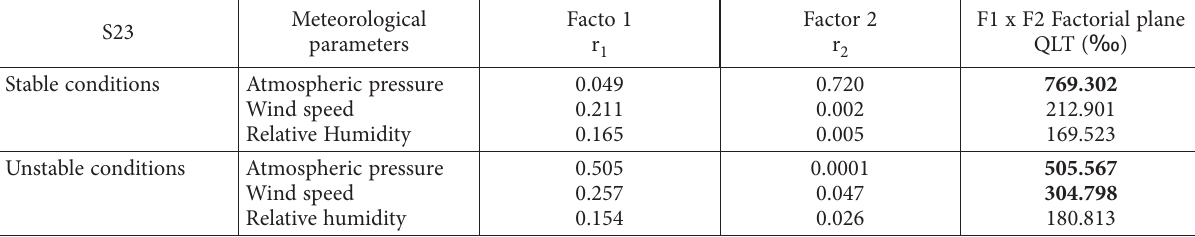
Table 6. Representation qualities (QLT) of selected meteorological parameters as a function of the two first axes of the (1x2) factoriel plane (‰)(Case of S23 site- the threshold of significance = 250 for p < 0.05 and n = 22)